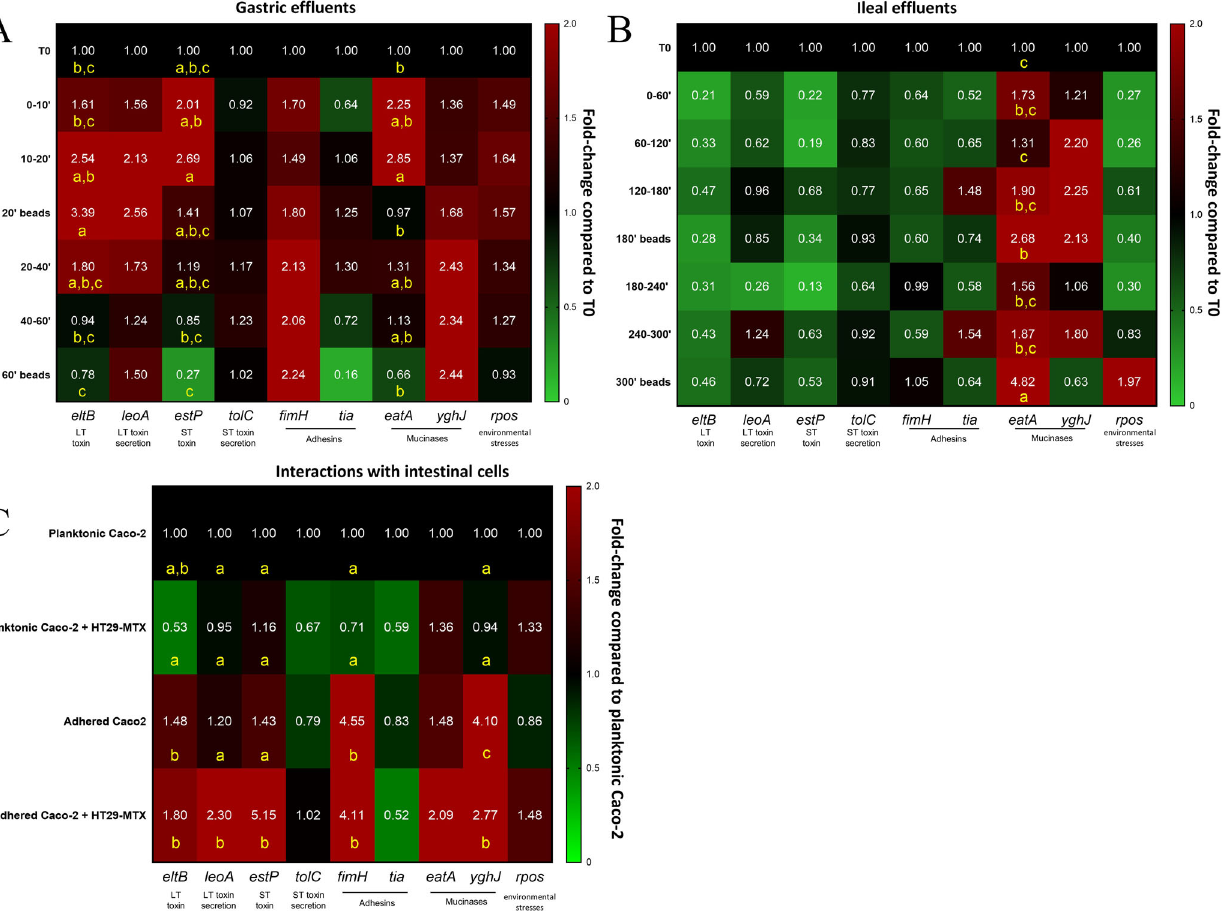
Fig. 3 Dynamics of virulence gene expression in planktonic and adhered ETEC bacteria during gastrointestinal transit and interactions with intestinal cells. ETEC virulence gene expression was analyzed by RT-qPCR in the gastric ( A ) and ileal ( B ) ef fl uents of the TIM-1 model inoculated with 10 10 CFU and in cellular experiments (MOI 100) involving Caco-2 cells cultivated with or without HT29-MTX mucus-secreting cells ( C ). Gene expression was analyzed over-time in the TIM-1 on planktonic bacteria or bacteria adhered to mucin beads ( A , B ) or intestinal cells ( C ). Results were expressed and colored according to fold-change expression compared to ETEC gene expression in the glass of water used to inoculate the TIM-1 model (T0) ( A , B ) or planktonic bacteria upon Caco-2 cells ( C ). Assayed genes were estP (ST toxin), eltB (LT toxin), leoA (LT toxin output), tolC (ST toxin outpout), tia (adhesin), fi mH (minor component of type I pilus), yghJ (mucinase), eatA (mucinase) and rpos (environmental stress response). Results that are signi fi cantly different from each other according to Tukey ’ s multi-comparison are grouped under different yellow letters ( p <